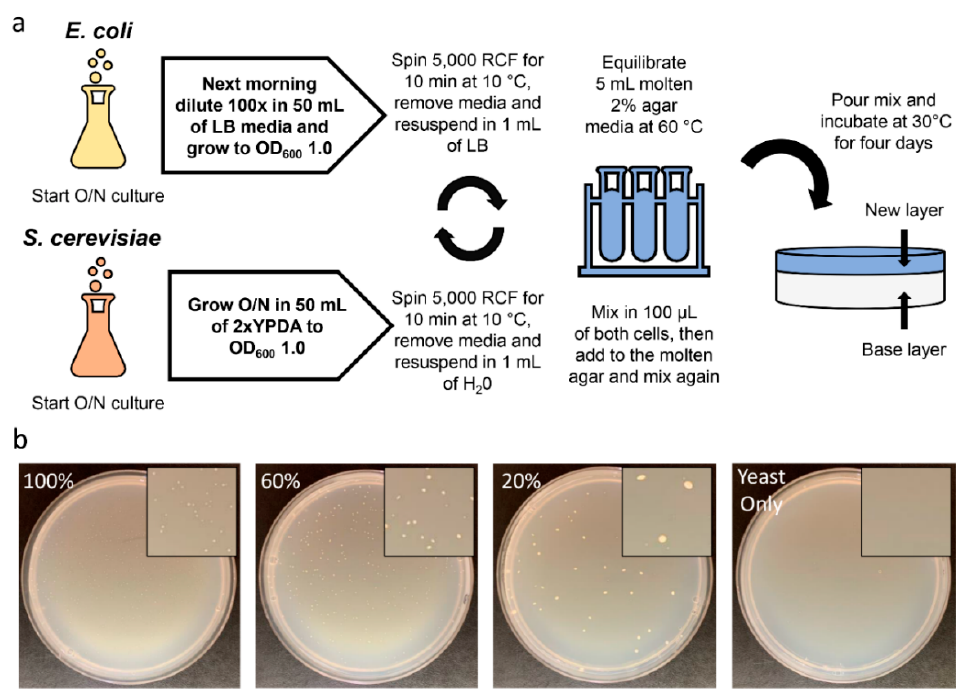
Figure 3. Optimized protocol for conjugation in solid media: ( a ) Schematic for the final protocol for conjugation from donor E. coli to recipient S. cerevisiae within solid media and ( b ) comparison of using 100%, 60%, and 20% of the optimized 100 µL/100 µL donor and recipient cell ratio. Yeast only setup was used as a negative control.